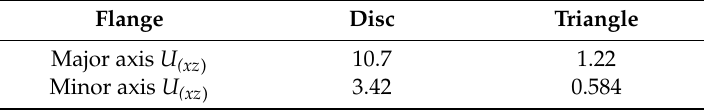
Figure 10. Motion trajectories of contact point: ( a ) disc-shaped flange at frequency 95.8 kHz; ( b ) triangle flange at frequency 96.2 kHz. Table 3. Length of major and minor axes, µ